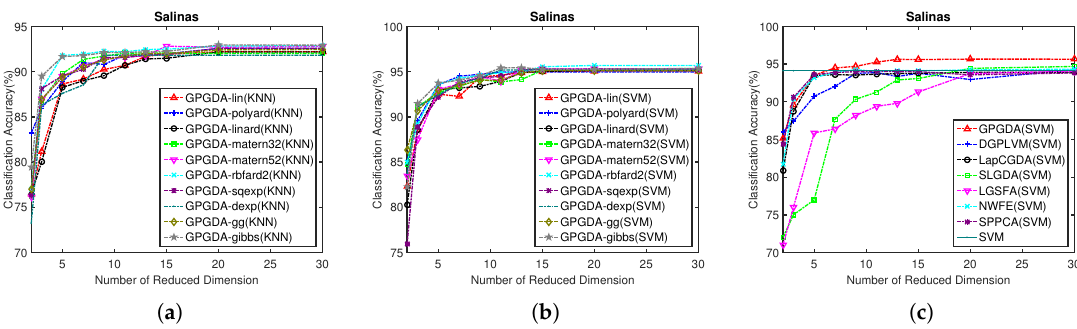
Figure 9. Classification accuracy w.r.t. different kernels and different dimensionality of the projection space on Salinas data: ( a ) KNN classification results of GPGDA based on different kernels; ( b ) SVM classification results of GPGDA based on different kernels; and ( c ) SVM classification results of all the DR methods based on different